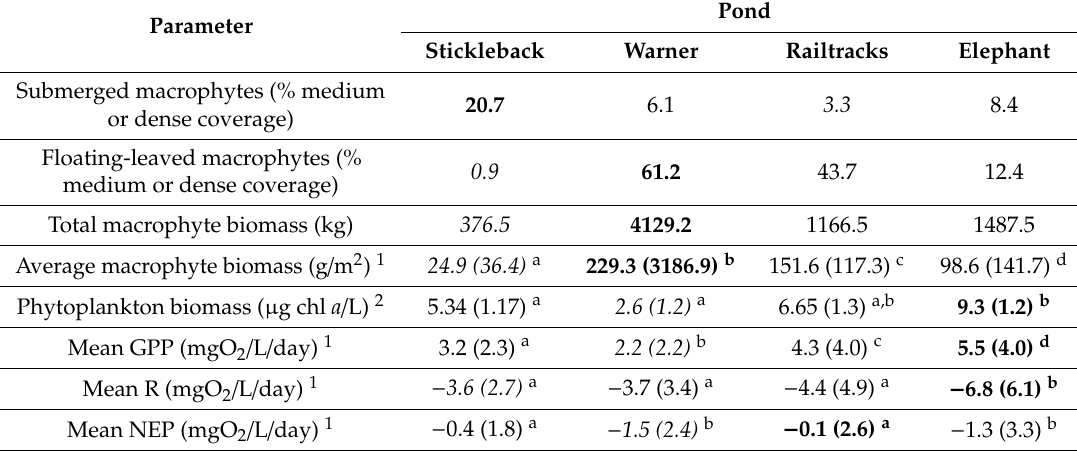
Figure 4. Maps of the extent of submerged macrophytes in four ponds in east-central Minnesota, USA. Table 3. Amounts of various primary producers (macrophytes and phytoplankton) and ecosystem metabolism measures (GPP—Gross Primary Production, R—Respiration and NEP—Net Ecosystem Production) from four ponds in east-central Minnesota. Within parameters, values with the same letter are not significantly di ff erent from one another (Tukey’s post hoc test). Cells labeled in bold show the pond with the maximum value of a parameter, while those in italics show the pond with the minimum